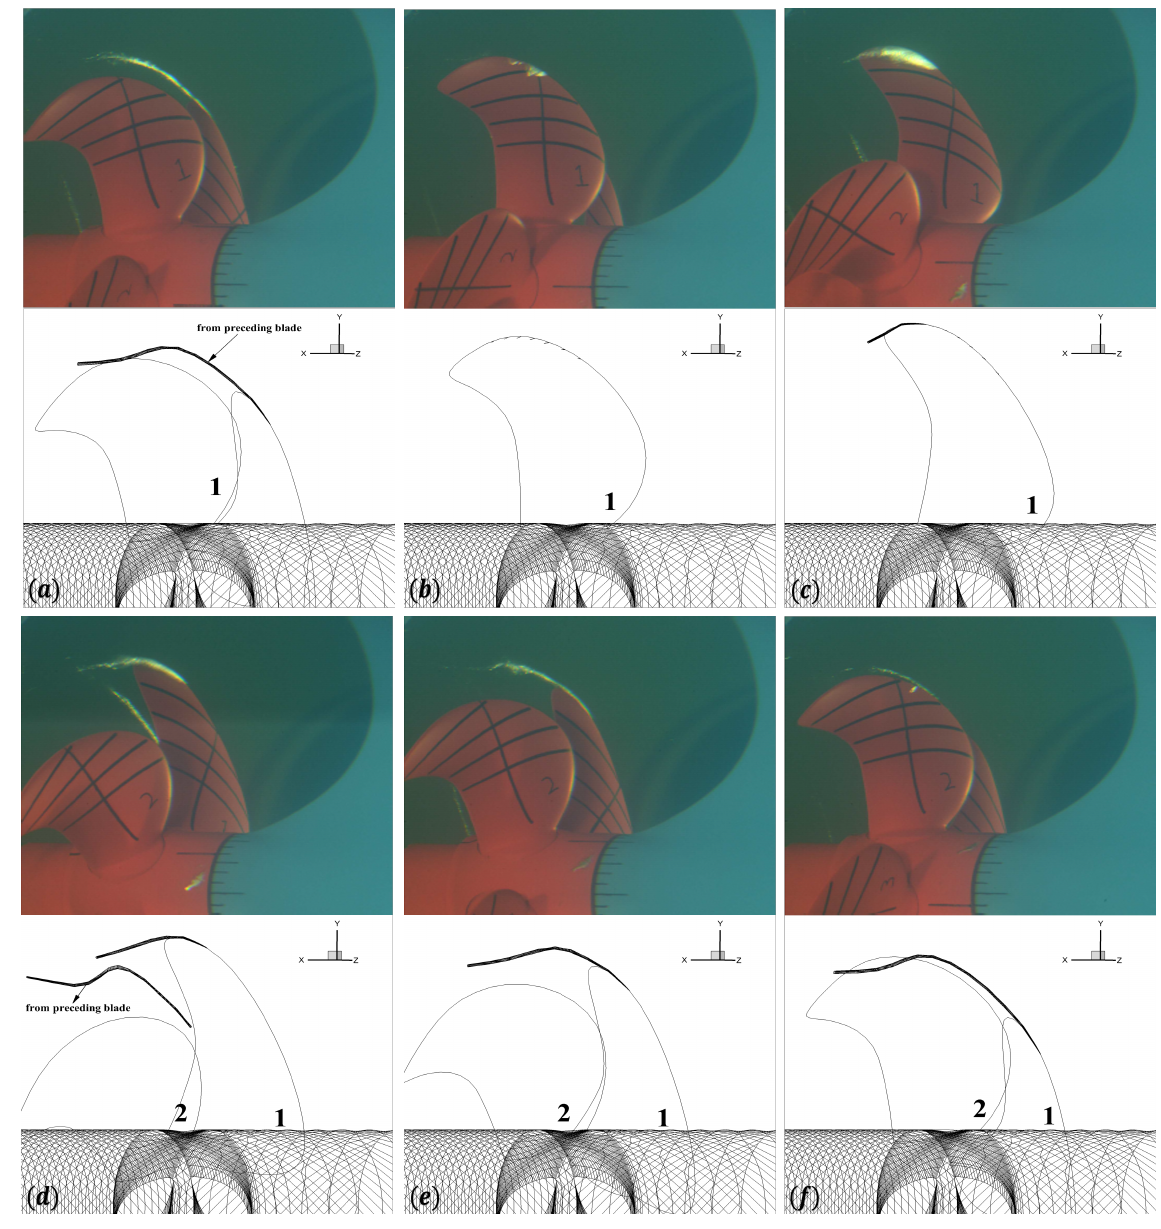
Figure 30. Comparisons of the tip vortex caivty predicted by BEM (bottom of every pair) with the experiments for SSPA P2772 propeller; Key blade angle: ( a ) 340 ◦ , ( b ) 0 ◦ , ( c ) 20 ◦ , ( d ) 40 ◦ , ( e ) 60 ◦ , and ( f ) 80 ◦